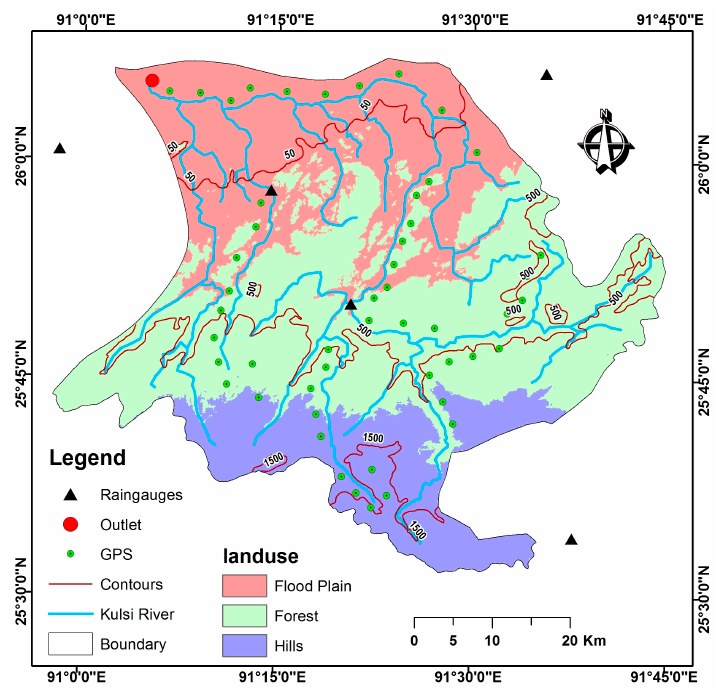
Figure 2. Location of rain gauges, GPS stations, and discharge site.